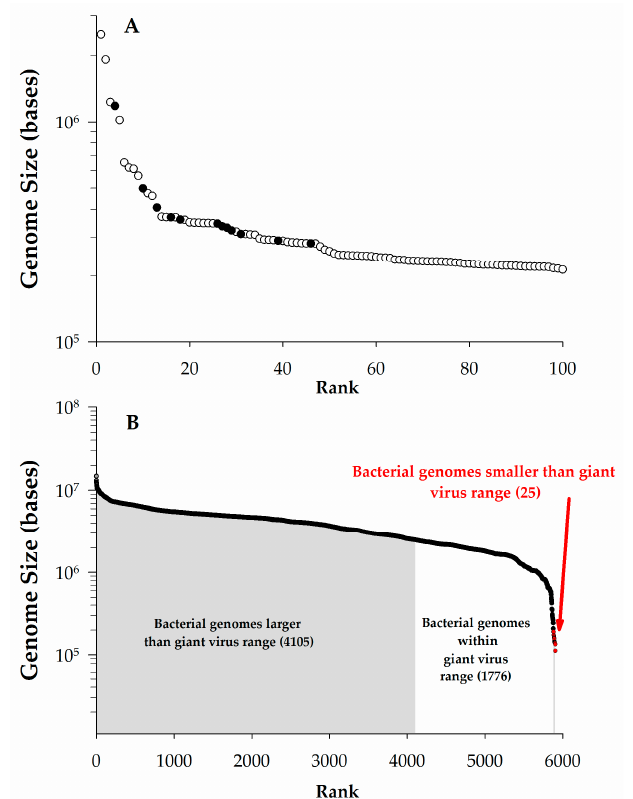
Figure 1. The scale of giant virus genomes. ( A ). Genome size vs. rank plot for the largest 100 complete viral genomes as of January 2016 from National Center for Biotechnology Information (NCBI). Data points noted ( ● ) were previously used in discussion by Claverie et al. [3] to define giants viruses as having genomes > 280 kb, open circles ( ○ ) represent additional data; ( B ). Genome size vs. rank order of completed bacterial genomes in NCBI as of January 2016. Sizes are color ‐ coded to match the ranges of giant virus genomes.